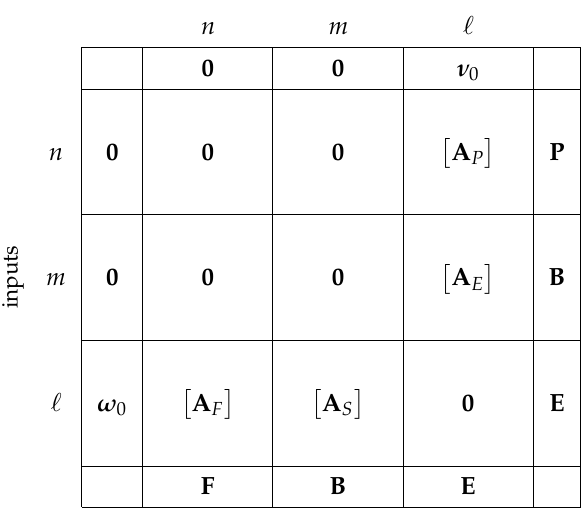
Figure 4. Productive table of an energy